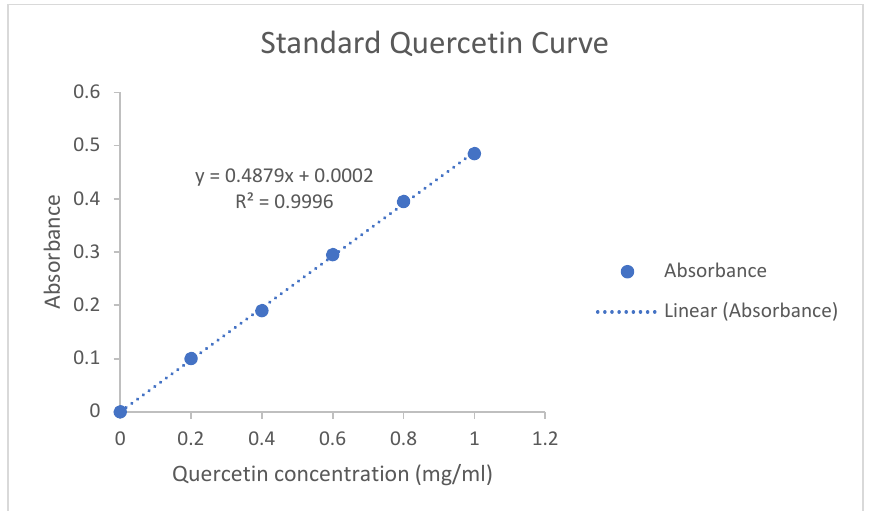
Figure 2. Standard quercetin curve for total flavonoid content.